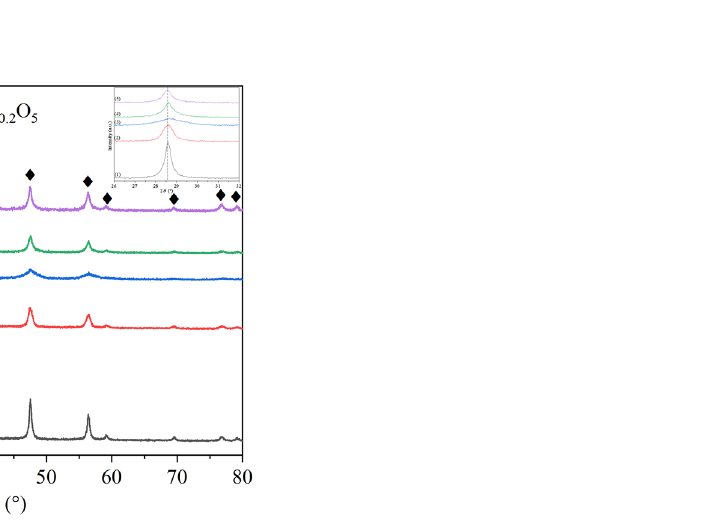
Figure 3. XRD patterns of cerium manganese catalysts: (1) CM-Na; (2) CM-NaC; (3) CM-NC; (4) CM-N; (5)